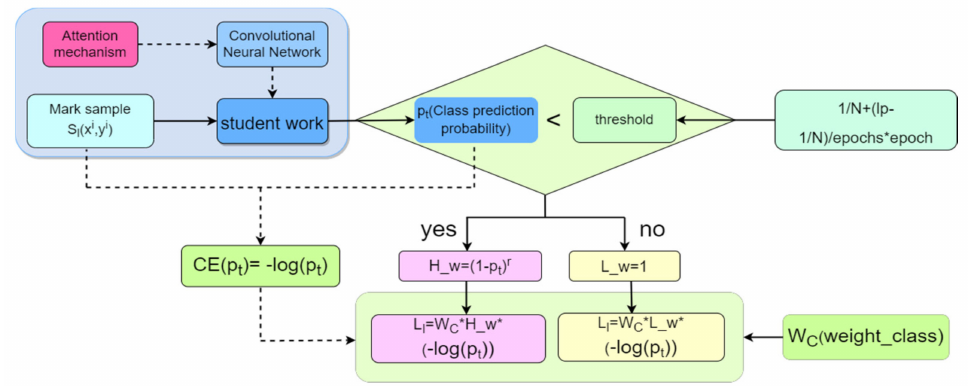
Figure 3. A detailed description of our semi-supervised framework supervision